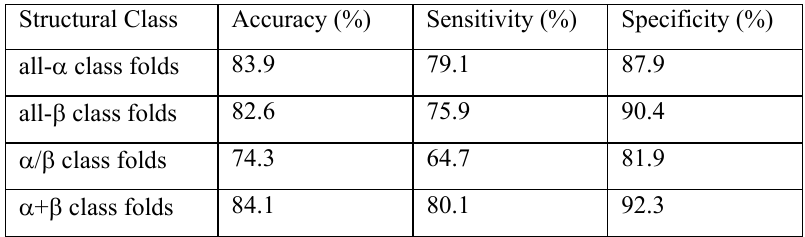
Table 4: The five-fold cross-validation accuracies, sensitivities and specificities obtained for individual structural-class folds using 711F